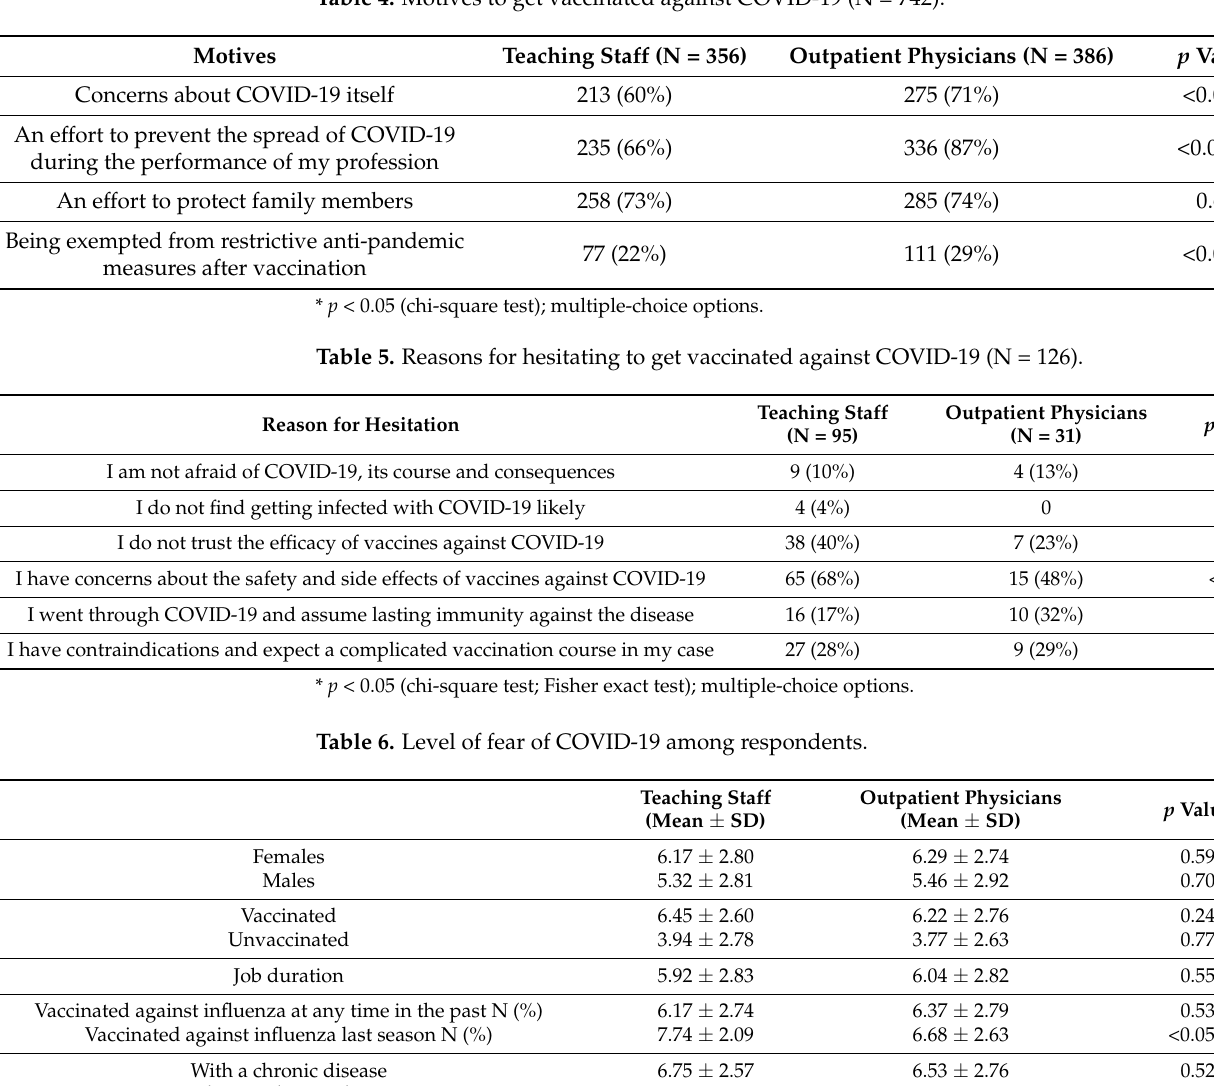
Table 4. Motives to get vaccinated against COVID-19 (N = 742).